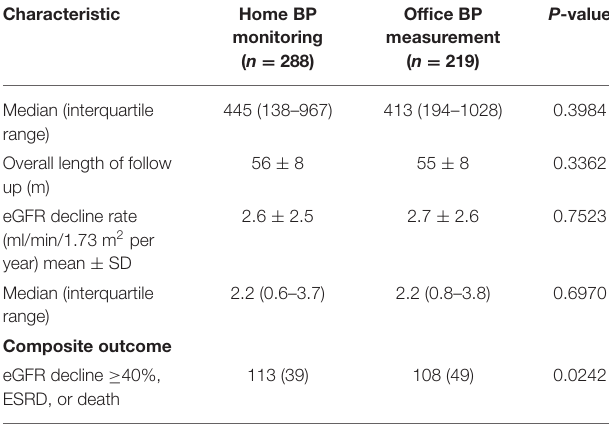
TABLE 2 | Characteristics of 507 CKD patients in relation to home BP and office BP